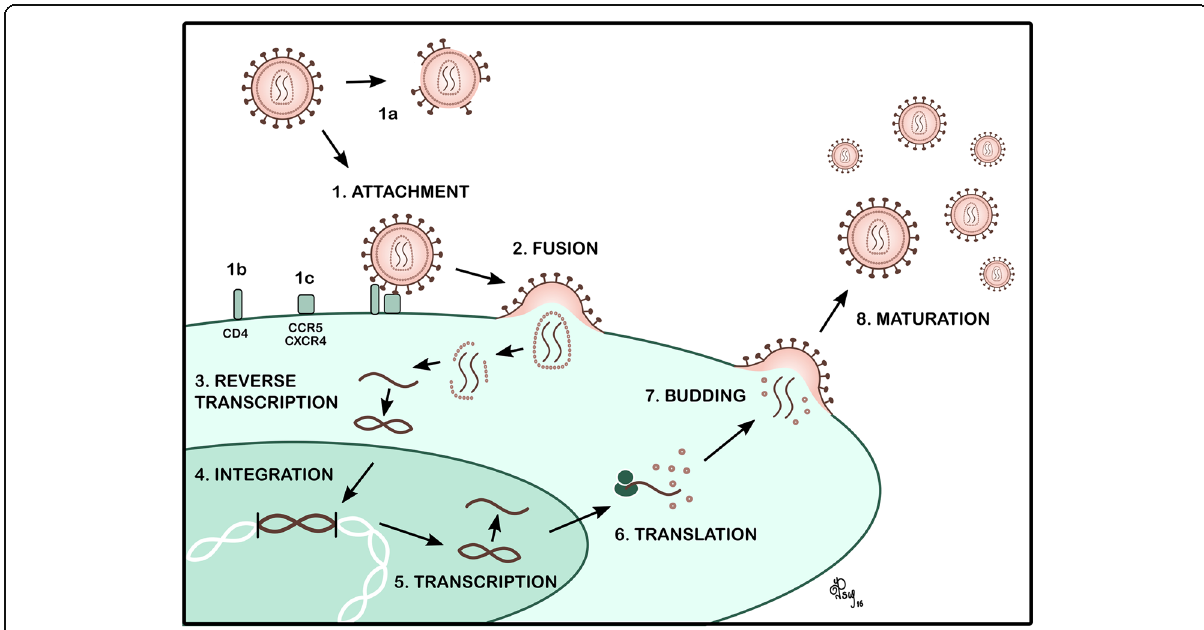
Fig. 1 Action mechanism of animal venom peptides or derivatives at different retrovirus replication cycle phases. ( 1 ) The ChTx and Scyllatoxin-based mimetics, such as CD4M33, inhibit the attachment of the viral glycoprotein (gp120) to the host cell receptor CD4. ( 1a ) The peptides cecropin A, magainin 2, papuamide A, dermaseptin DS4, caerins 1.1 and 1.9 and maculation 1.1 disintegrate the viral envelope. ( 1b and 1c ) The peptides CD4M33, BmKn2, Kn2-7, polyphemusin, tachyplesin, immunokine and p3bv obstruct the interaction of the viral gp 120 to the CXCR4 and CCR5 co-receptors. ( 2 ) The peptides miramides A – H inhibit the fusion of the viral envelope to the host cell membrane. ( 3 ) The peptides melittin, didemnis A, B and C interfere with the reverse transcription process, aborting the synthesis of double-stranded viral DNA. ( 6 ) The peptides hecate and TVS-LAO act in the post-translation process, in the cleavage of the GAG/POL protein precursor thus interfering in the assembly of the viral capsid and in